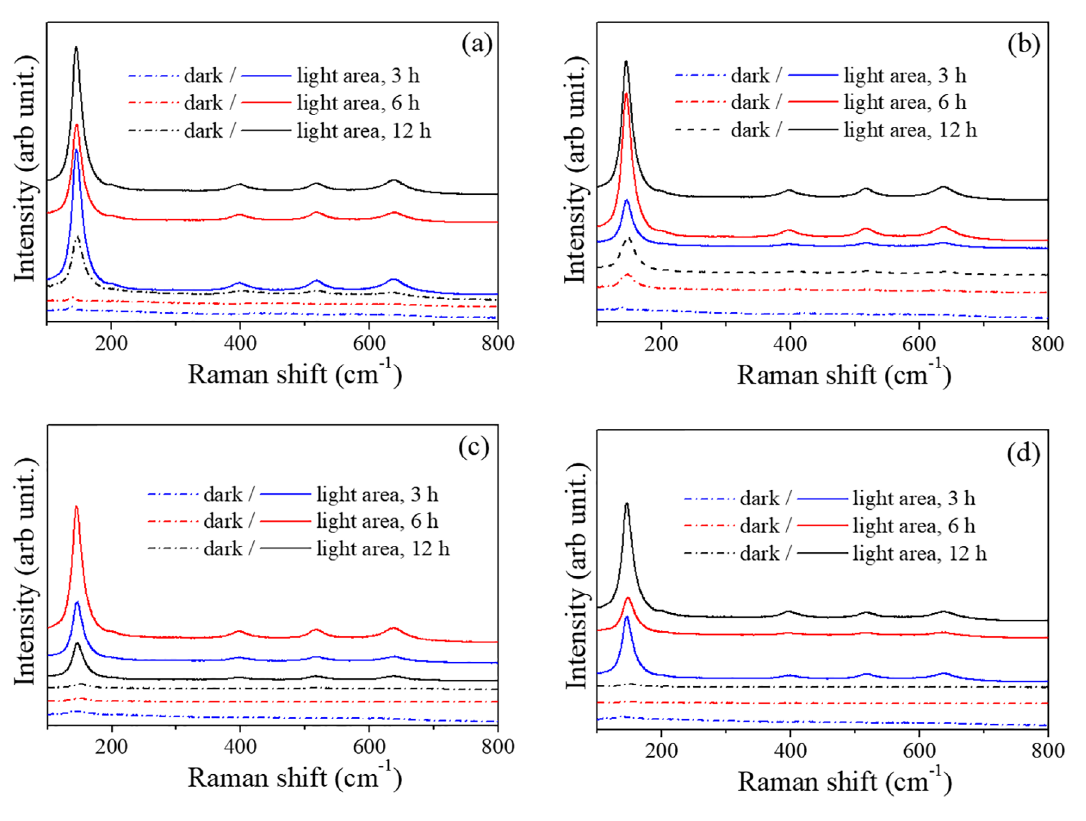
Figure 6. Raman spectra obtained for titanium oxide films after anodization in two different concentrations (mol L -1 ): 0.25 (a, c) and 2.5 (b, d) H PO solutions; on EP (a, b) and MP (c, d) 3 4